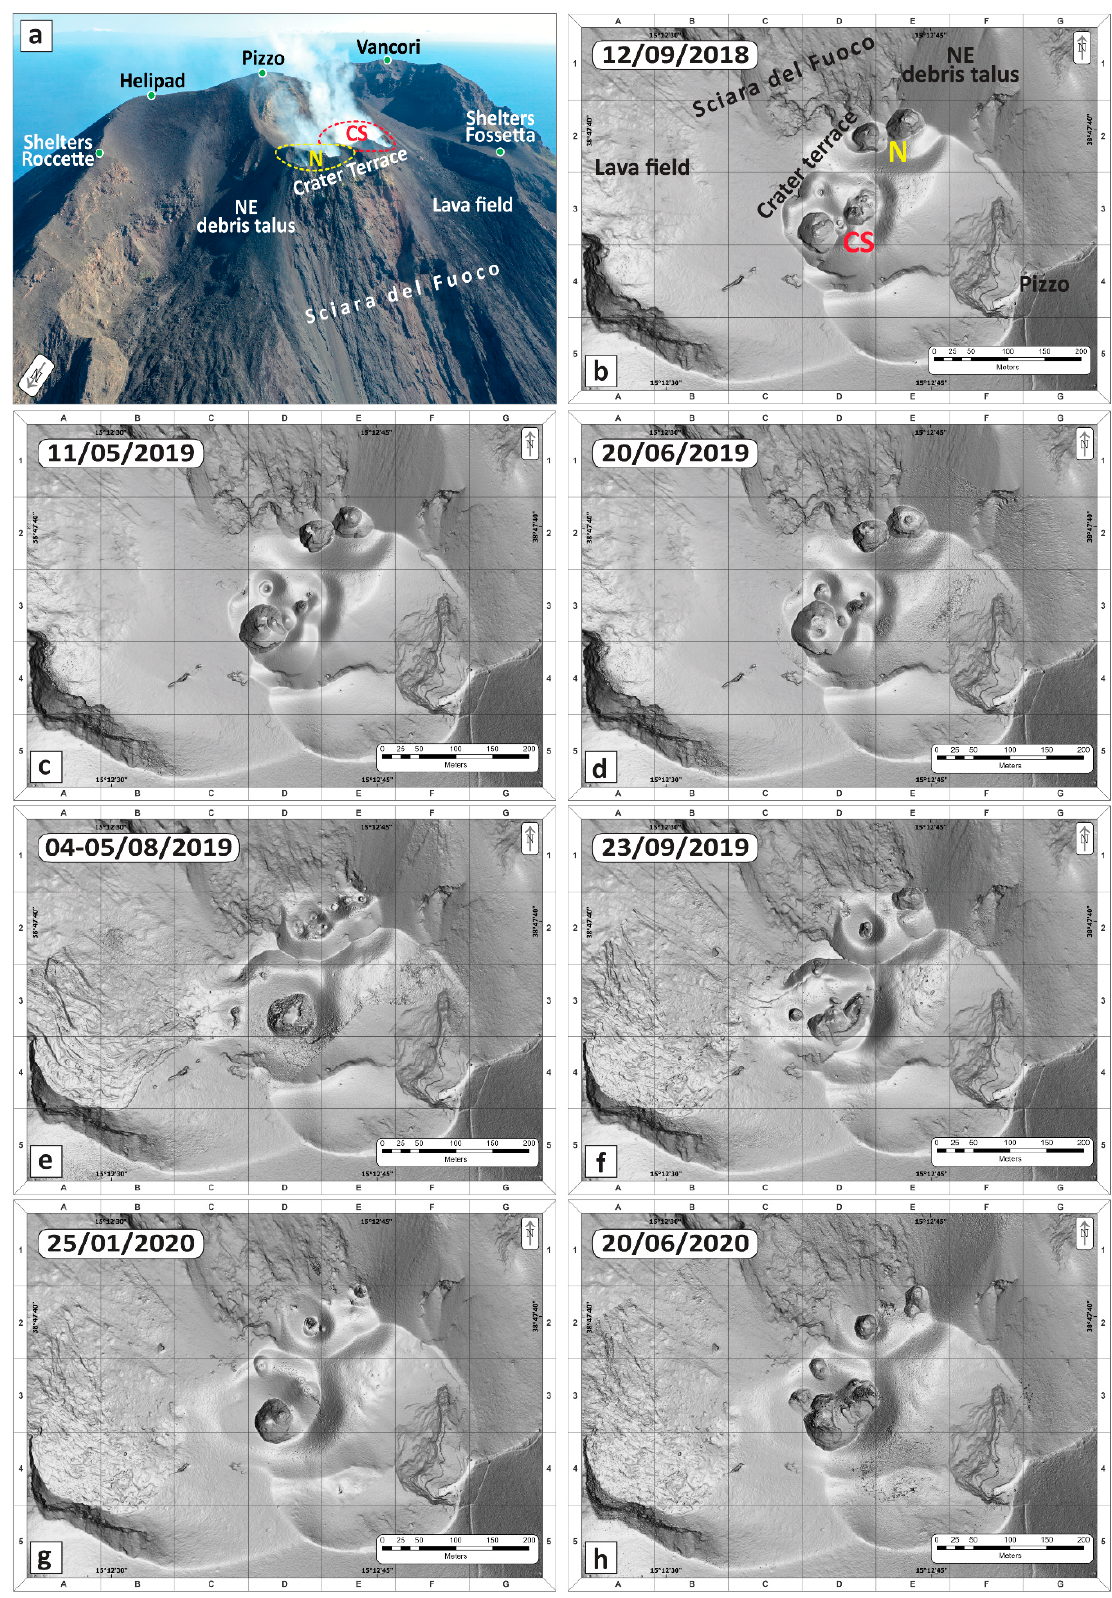
Figure 3. ( a ) Location map; ( b – h ) Multidirectional hillshades of the Digital Surface Models of Stromboli’s summit, in chronological order. Description in Section 3.1.